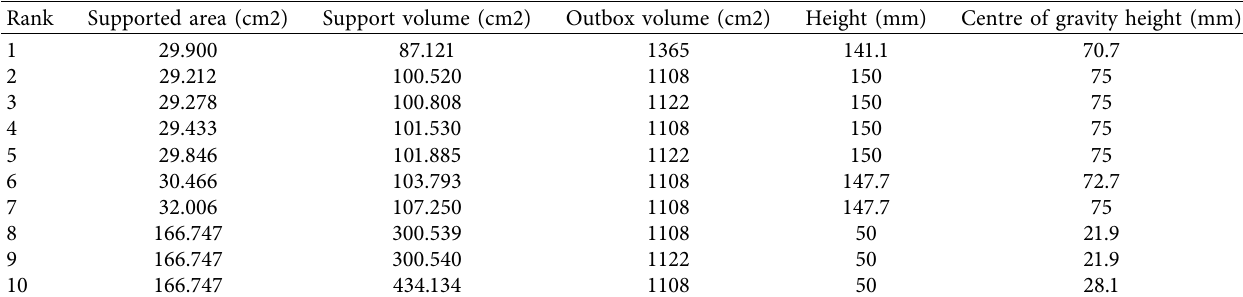
Table 4: Variations of physical features are required based on the position to be